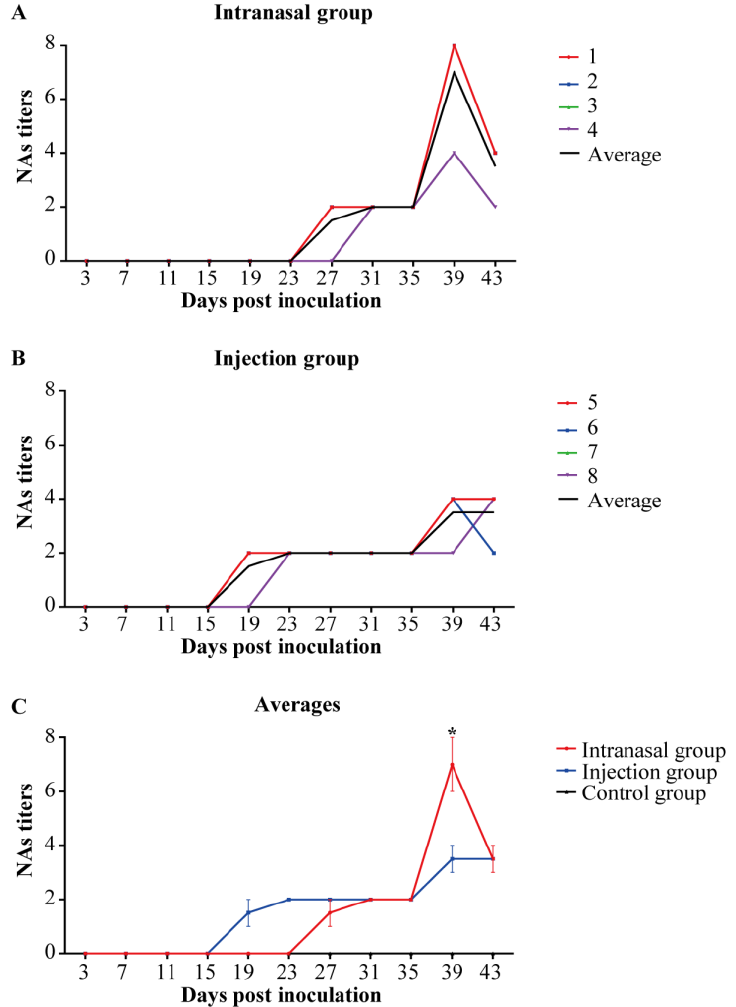
Figure 5. Anti-PRRSV serum NAs titers. The micro-neutralization assay results were determined by evaluating PRRSV RNA with RT-qPCR. NAs titers were below 1:2 in the control group in the study. ( A , B ): Colored lines represent the individual animals, and black lines represent the mean value of each group. Numbers (1–9) represent the individual pig numbers. ( A ) Anti-PRRSV serum NAs titers in the intranasal group. ( B ) Anti-PRRSV serum NAs titers in the injection group. ( C ) The averages of serum NAs titers within each group. The graph illustrates the mean ± SEM. Statistical differences were determined using the t -test (* p < 0.05). Comparisons were between the Intranasal and the Injection groups.